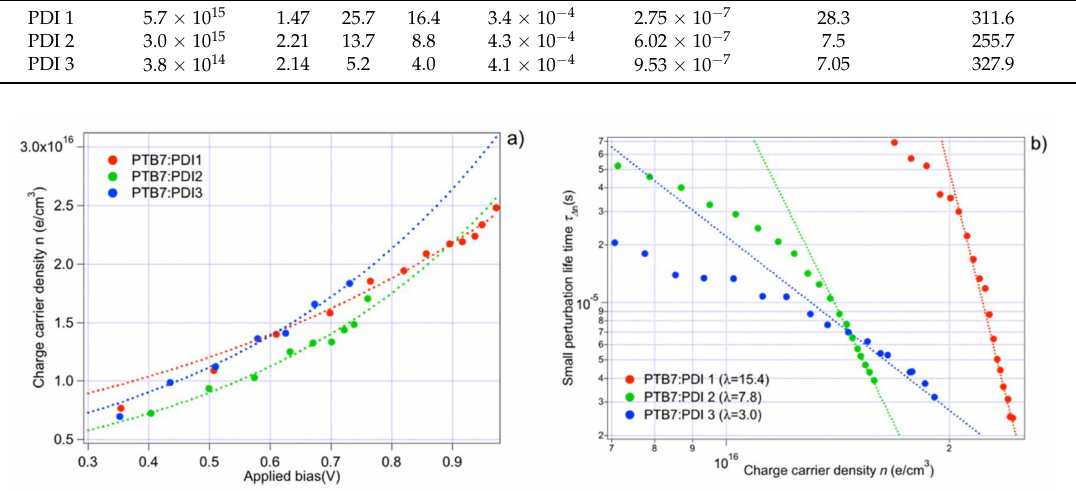
Figure 5. ( a ) Charge density (n) as a function of the open circuit voltage determined from CE measurement. The curves are fitted to an exponential growth of the form n = n 0 e ( γ Voc ) (dotted line) whose parameters are reported in Table 2; ( b ) Carriers’ lifetime measured using TPV as a function of device open circuit voltage. The curves are fitted to a power decay of the form τ ∆ n = τ ∆ n 0 · n − λ (dotted line), whose parameters are reported in Table 2.